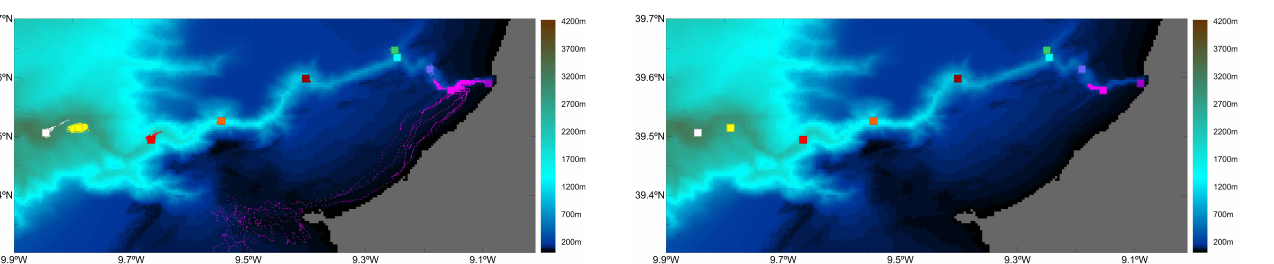
Fig. 6. Snapshot of the 429µm OMA dispersion patterns after 22days of simulation.